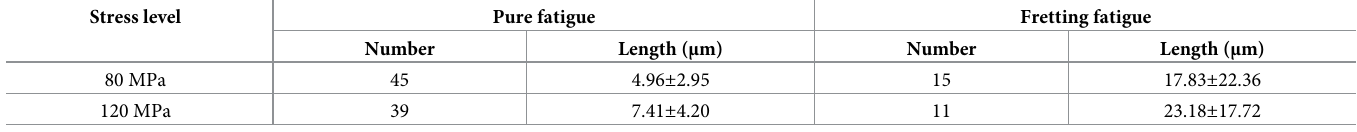
Table 3. The micro-crack characteristics on 2000X-FESEM images (in crack propagation regions). Stress